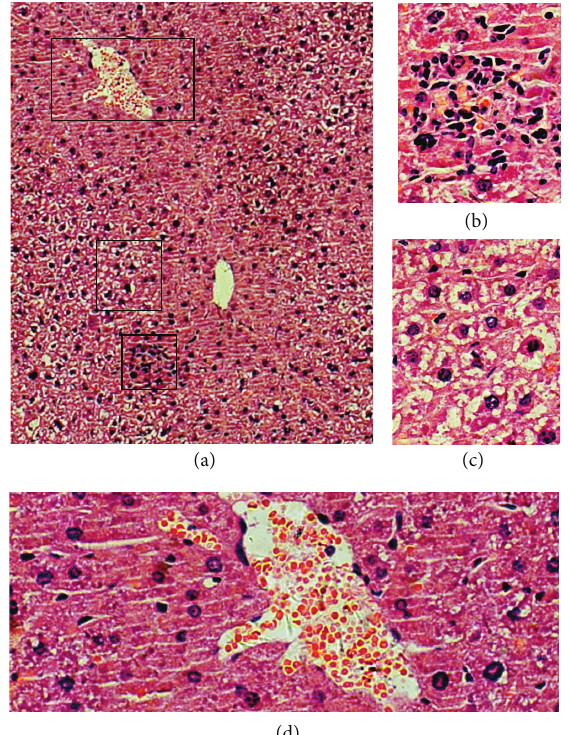
Figure 3: Morphological changes in liver 24 hours after CLP- induced sepsis in hematoxylin and eosin-stained section. Black squares in (a) were magnified into (b), (c), and (d). Spotty necro- sis and infiltrations of inflammatory cells were observed in (b). Hepatocytes undergoing ballooning degeneration were observed in (c). Irregular central vein congestion were seen in (d). Original magnification was × 200 for (a) and × 400 for (b), (c), and (d).